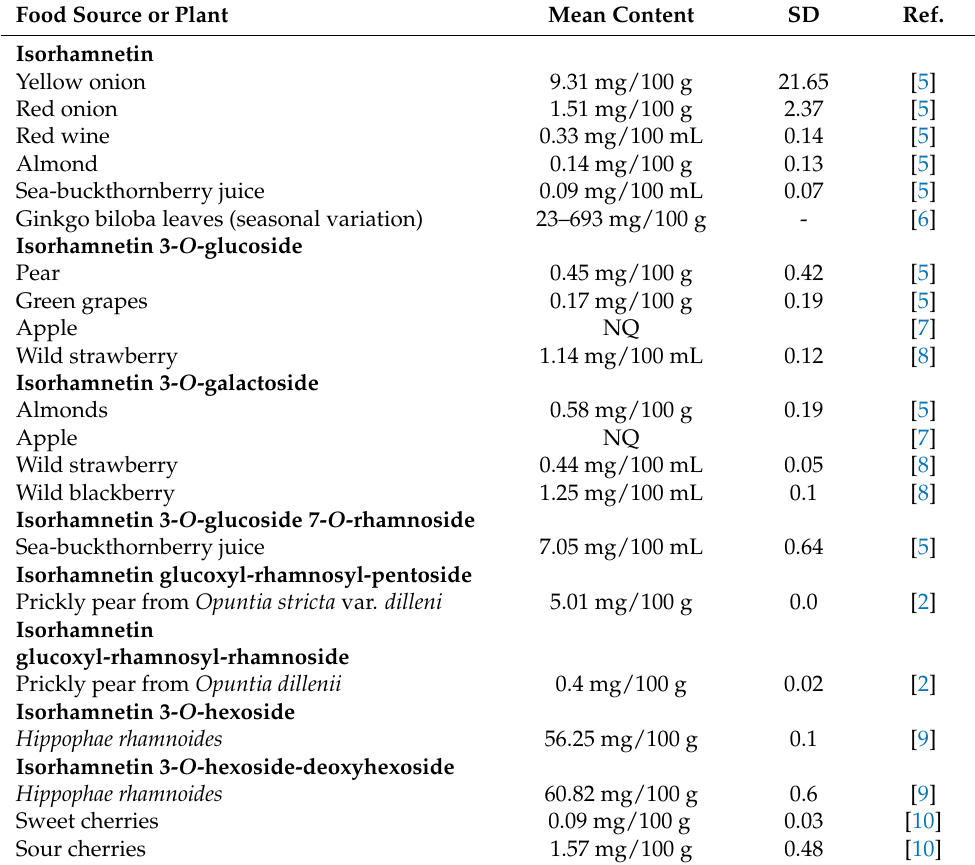
Figure 1. Chemical structure of isorhamnetin. Table 1. Content of isorhamnetin and some of its glycosides in different foods and plants.